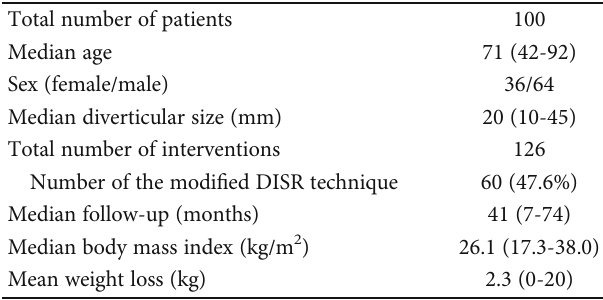
Table 2: Demographic and clinical characteristics.